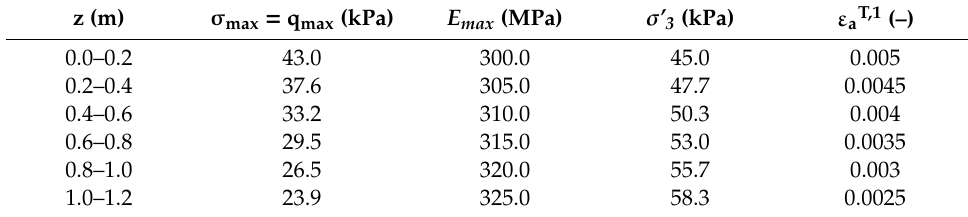
Table A5. SHML input parameters in the footing settlement calculations.